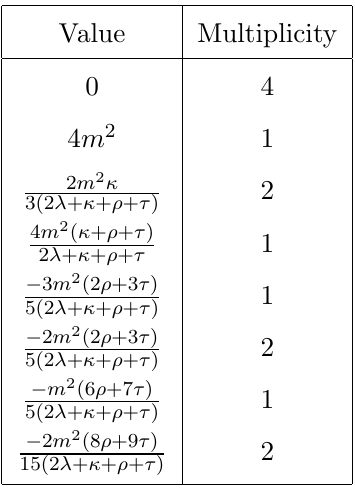
Table 3 . Scalar mass eigenstates for the SSB pattern SO(3) ! A 5 using a real 13 of SO(3).